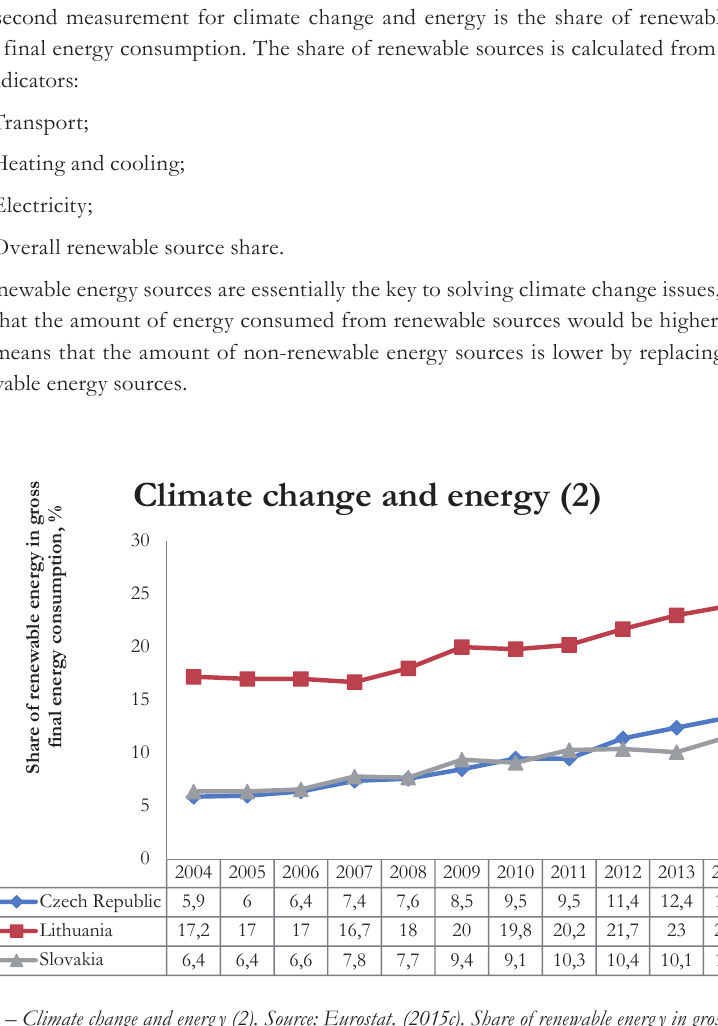
Fig. 3 – Climate change and energy (2). Source: Eurostat. (2015c). Share of renewable energy in gross final energy consumption. Retrieved February 22, 2016, from http://ec.europa.eu/eurostat/cache/metadata/DE/t2020_31_